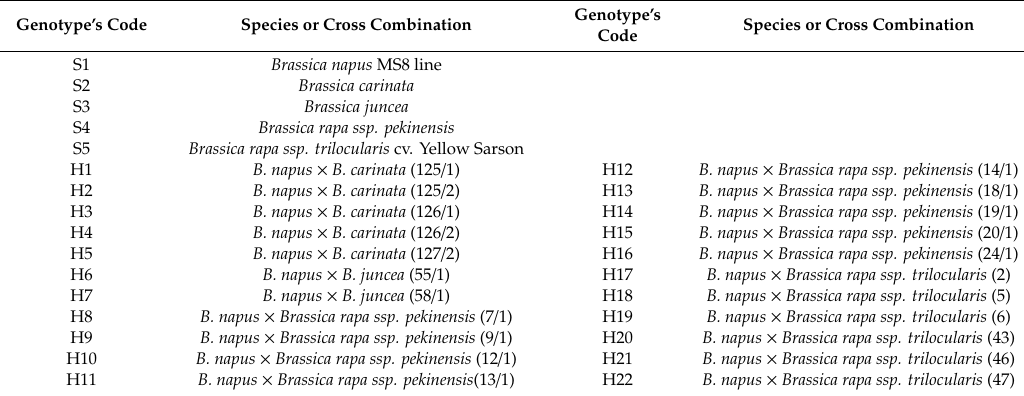
Table 1. List of Brassica species and interspecific hybrids used as a research material.